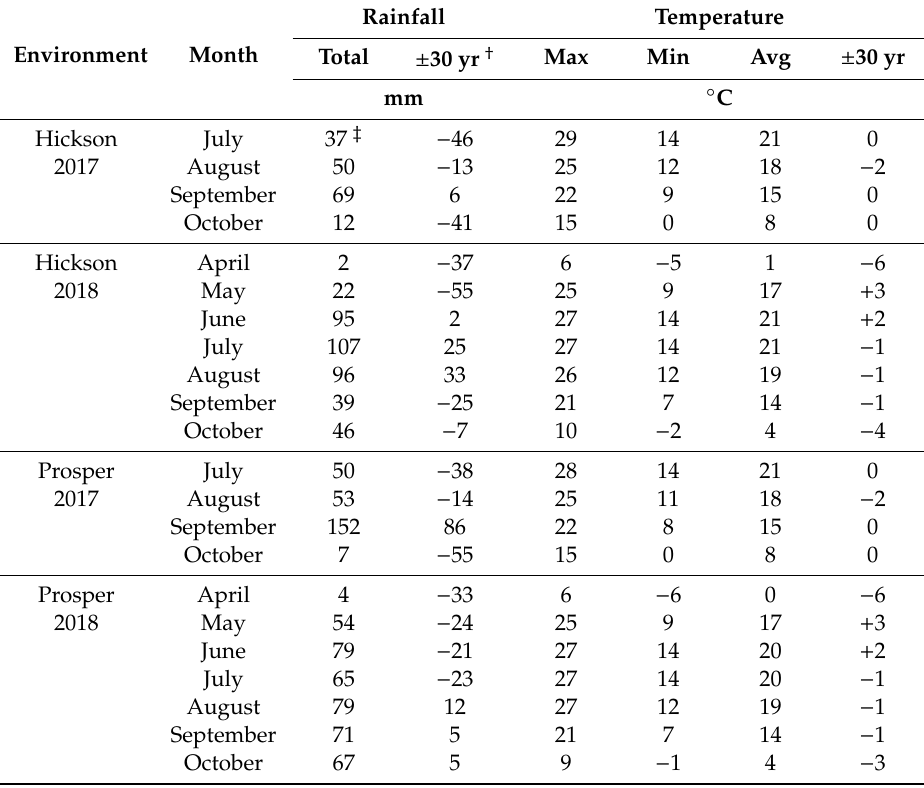
Table4. Totalmonthlyrainfall, temperature, anddi ff erencefromthe30-yraverageforfourenvironments at Hickson and Prosper, ND, USA, in 2017 and